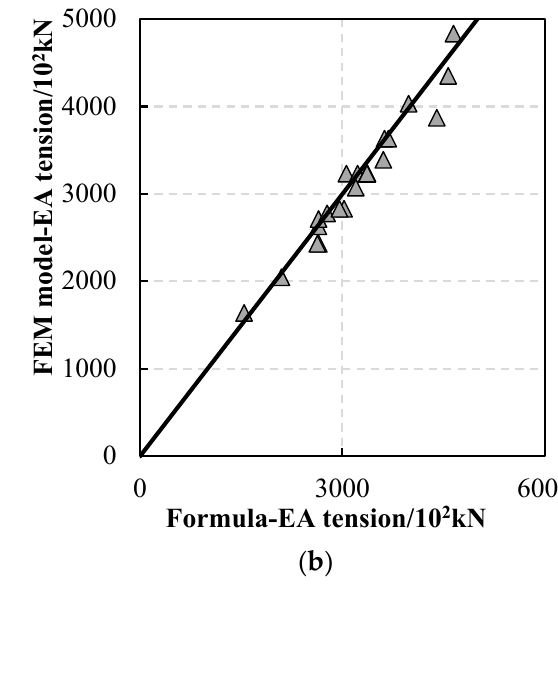
Table 12. Reliability verification of the stiffness formula.